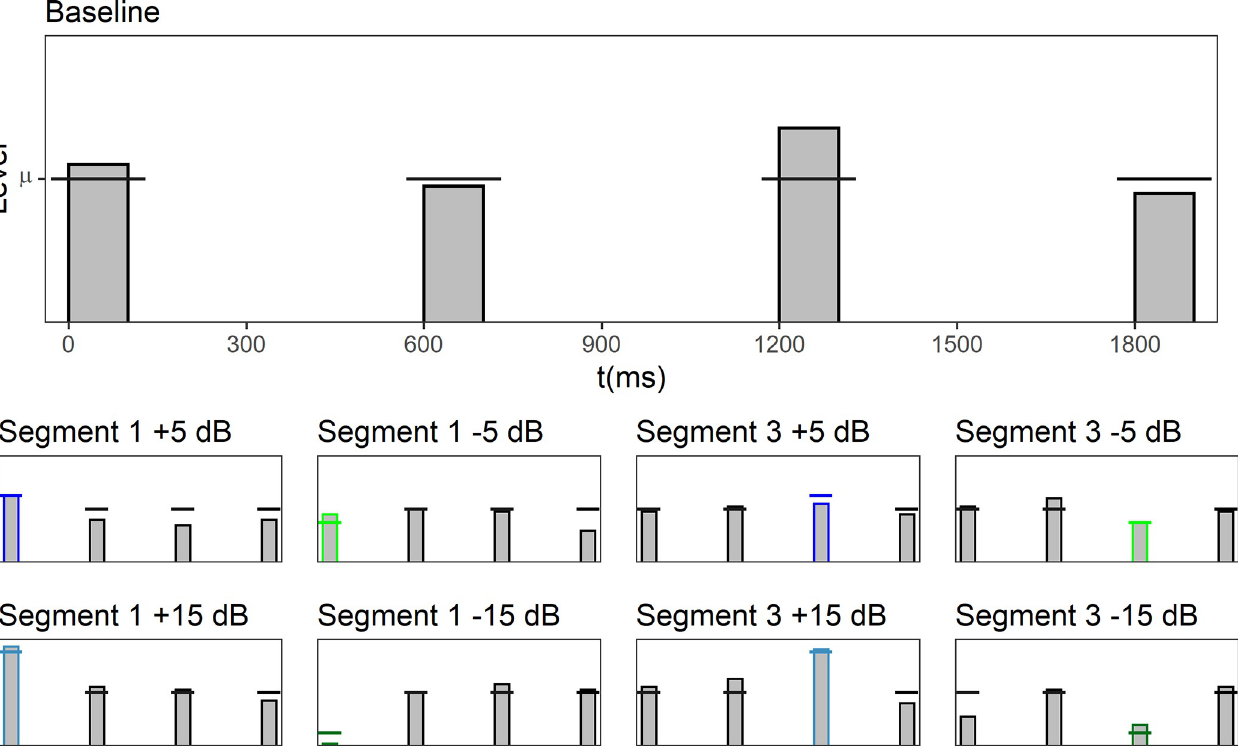
Fig 1. Level profiles in the nine different conditions presented in Experiment 1. The stimuli consisted of four 100-ms broadband noise segments. The horizontal lines in each panel display the mean sound pressure of the distribution from which the segment levels were drawn. The bars display the randomly selected segments levels within an example